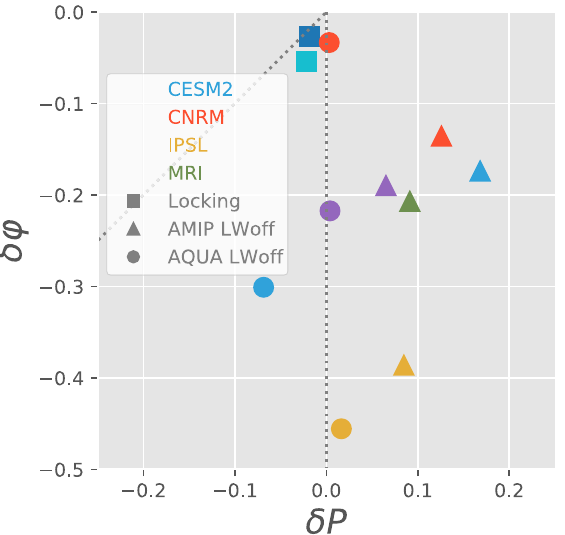
Fig. 3 The fractional change in extreme precipitation fraction ( δ φ ) against tropical ocean mean precipitation ( δ P ). Dashed diagonal line in the upper left shows the one-to-one line, and a vertical line at δ P =